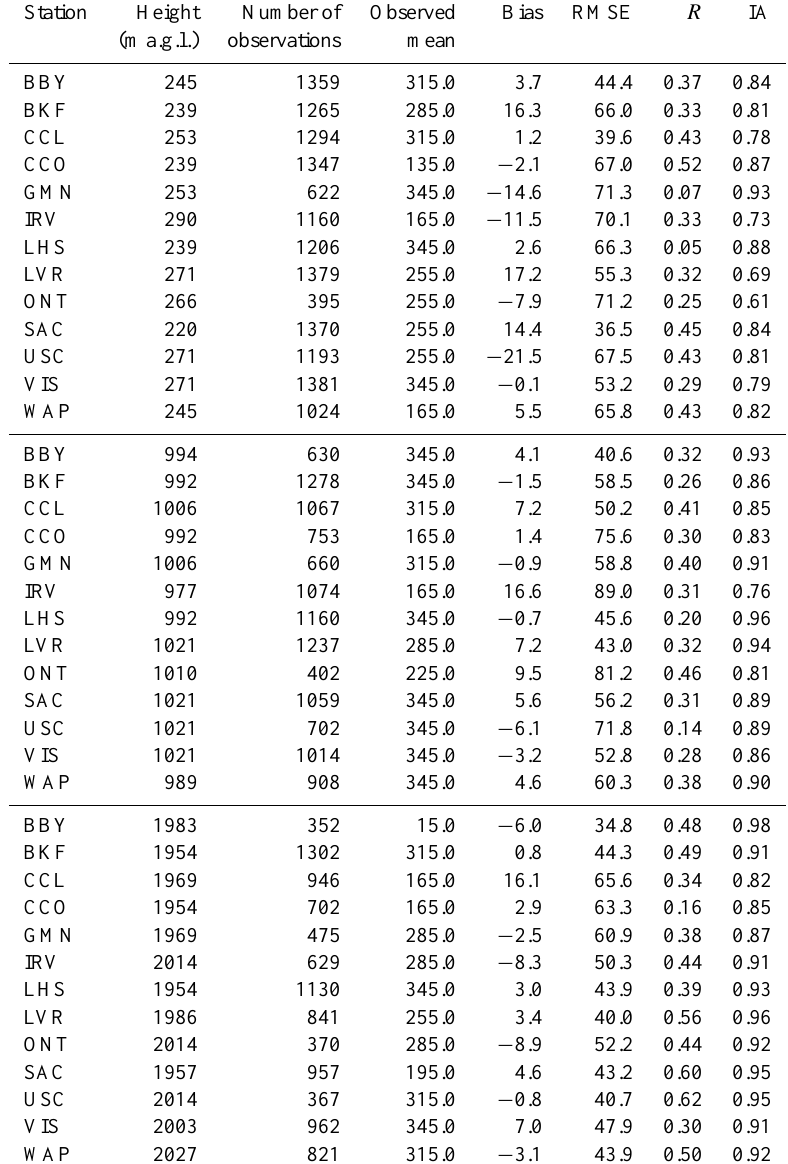
Table 7. Performance in simulated wind direction (degrees) in terms of bias, root-mean-square error (RMSE), correlation coefficient ( R ), and index of agreement (IA) for the radar wind profilers shown in Fig. 1c. Statistics given for range gates close to ∼ 250, ∼ 1000, and ∼ 2000ma.g.l. Statistics at TRK are not given because relatively little data were available May and June of